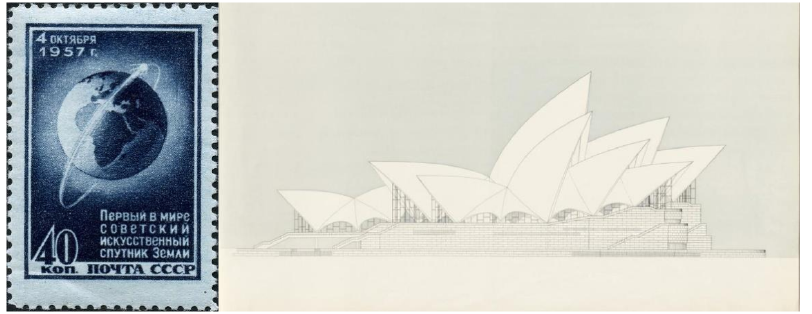
Figure 7. Left : image of the orbit traced by Sputnik space satellite, launched by the Soviet Union on 4 October 1957 (www.wikipedia.org; last accessed 4 December 2021). Right : Sydney Opera House’s roof profiles as defined on the Red Book, 1958 (www.records.nsw.gov.au; last accessed 4 December 2021)